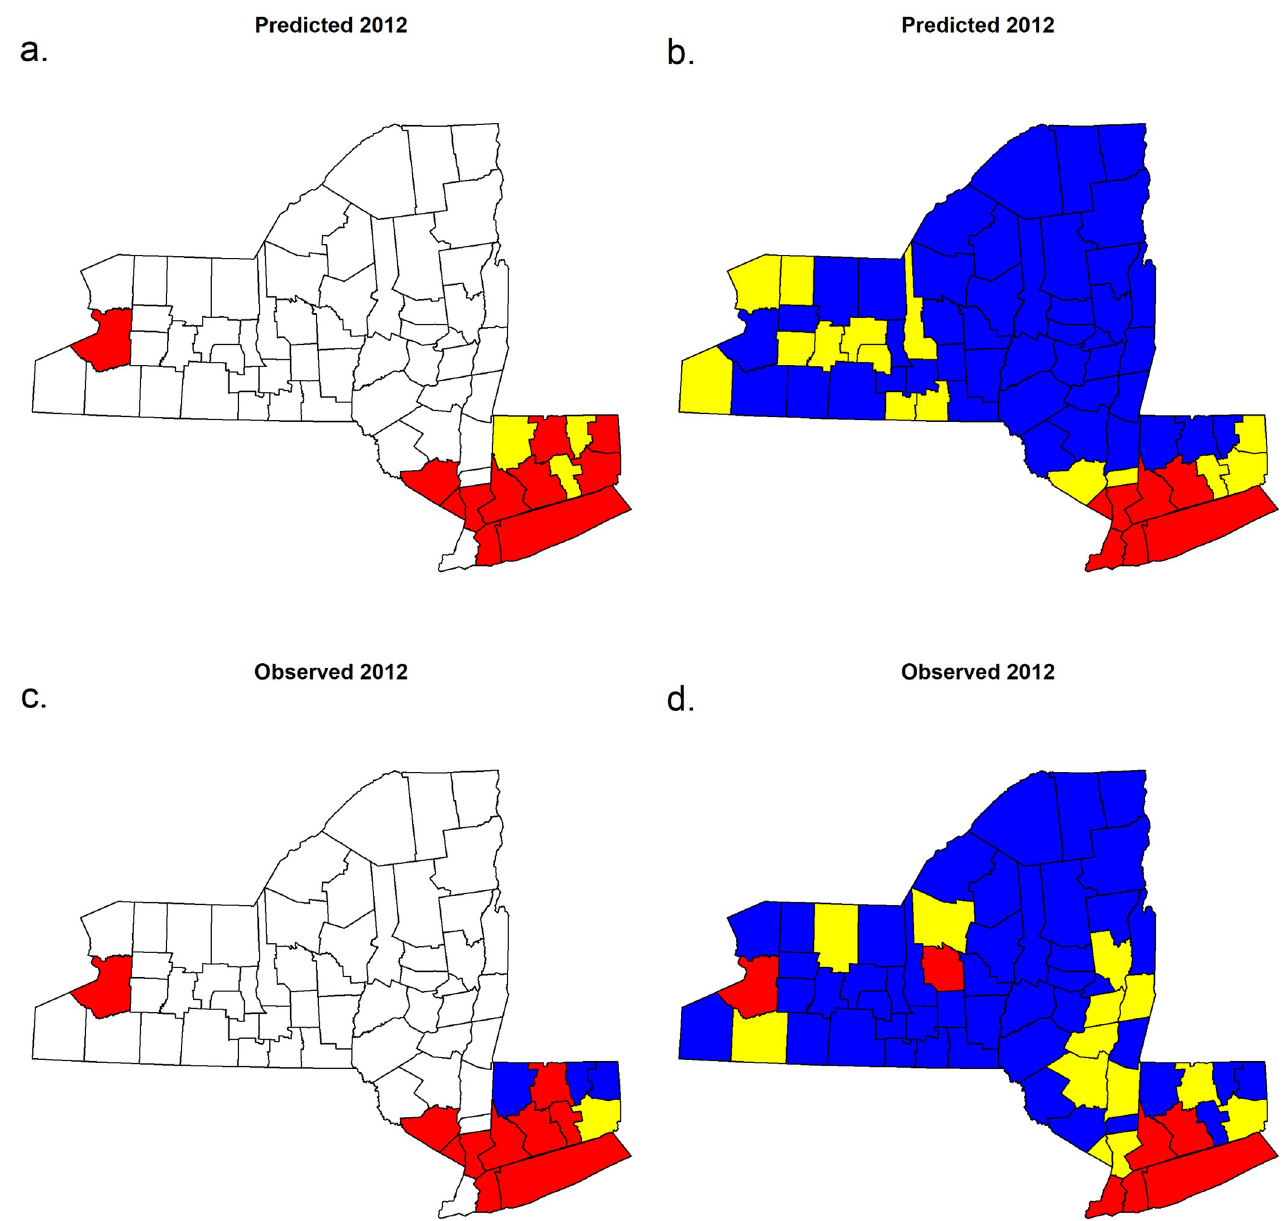
Fig 3. Predicted and observed WNV mosquito infection rates ( MLE , a, c) and human cases (b, d) for 2012, a particularly widespread WNV year. MLE thresholds from Little et al. [22]: blue corresponds to MLE < 1 mosquito per 1000, yellow corresponds to MLE 1–5 per 1000, and red to MLE > 5 per 1000. White indicates excluded counties for which we did not have mosquito surveillance data. For human cases (b, d), blue indicates no human cases, yellow indicates 1–5 cases, and red indicates more than 5